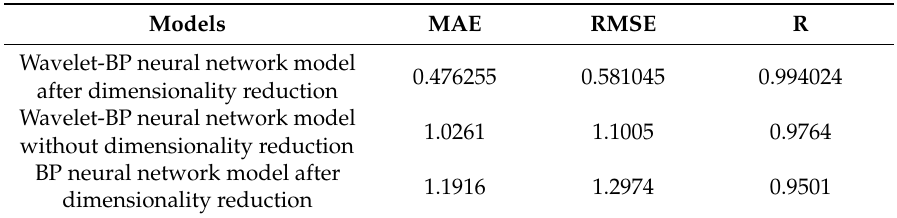
Figure 10. Comparison of the influence of wavelet decomposition on model prediction error: ( a ) prediction error of the wavelet-BP neural network model after dimensionality reduction and ( b ) prediction error of the BP neural network model after dimensionality reduction. Table 7. Index scores of three models.